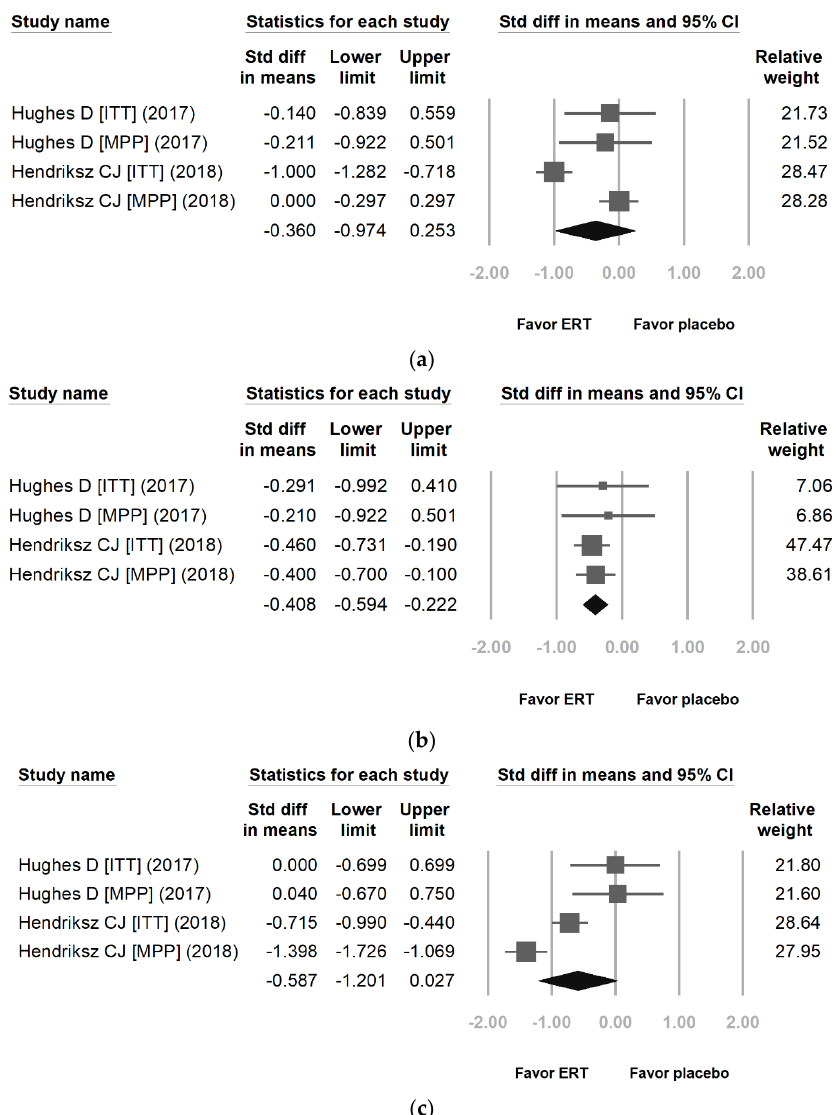
Figure 4. Proportional meta-analysis result for a pooled proportion from two cohort studies for MPS-Health Assessment Questionnaire (HAQ) of ( a ) self-care, ( b ) caregiver assistance, and ( c ) mobility in MPS IVA. The pooled proportions analysis showed that the difference in means of self-care, caregiver assistance, and mobility between the enzyme replacement therapy (ERT) group and the placebo treatment group were ( a ) − 0.360 [95% CI: − 0.974, 0.253; heterogeneity: I 2 = 87.08%, p < 0.001; overall effect: p = 0.049], ( b ) − 0.408 [95% CI: − 0.594, − 0.222; I 2 = 0.00%, p = 0.907; overall effect: p < 0.001], and ( c ) − 0.587 [95% CI: − 1.201, 0.027; I 2 = 87.13%, p < 0.001; overall effect: p = 0.041] (ITT: intention to treat; MPP: modified per protocol) [22,23]. (Reprinted/adapted with permission from Ref. [22], 2017, Hughes et al. and Ref. [23], 2018, Hendriksz et